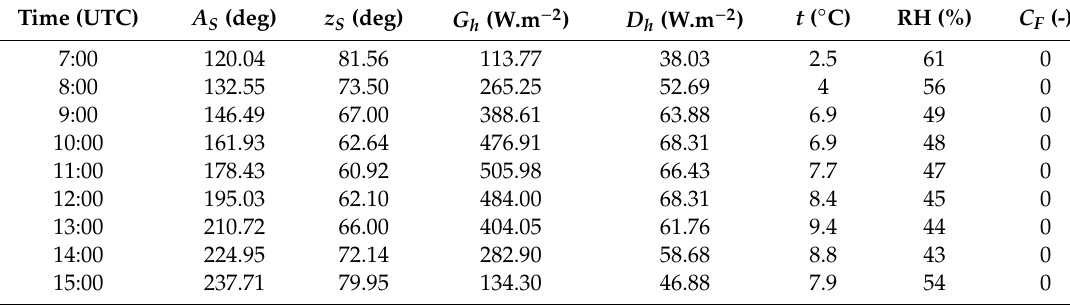
Table 1. Data collected at the Slovak Hydro-meteorological Institute (Bratislava, Slovakia)